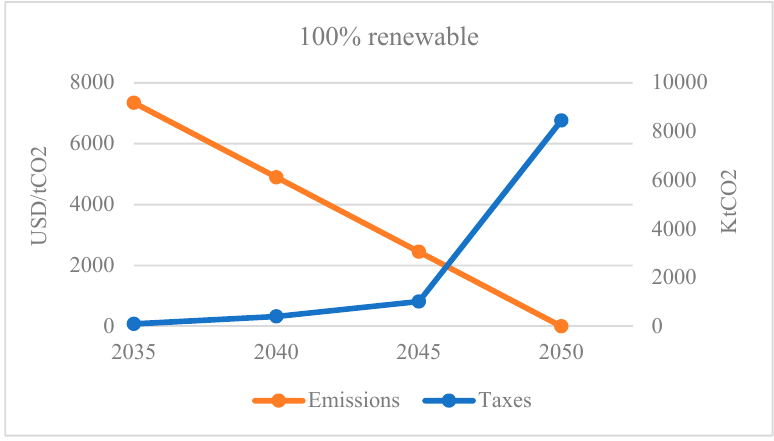
Figure 8. Emissions and taxes trajectory for the 100% renewable scenario.